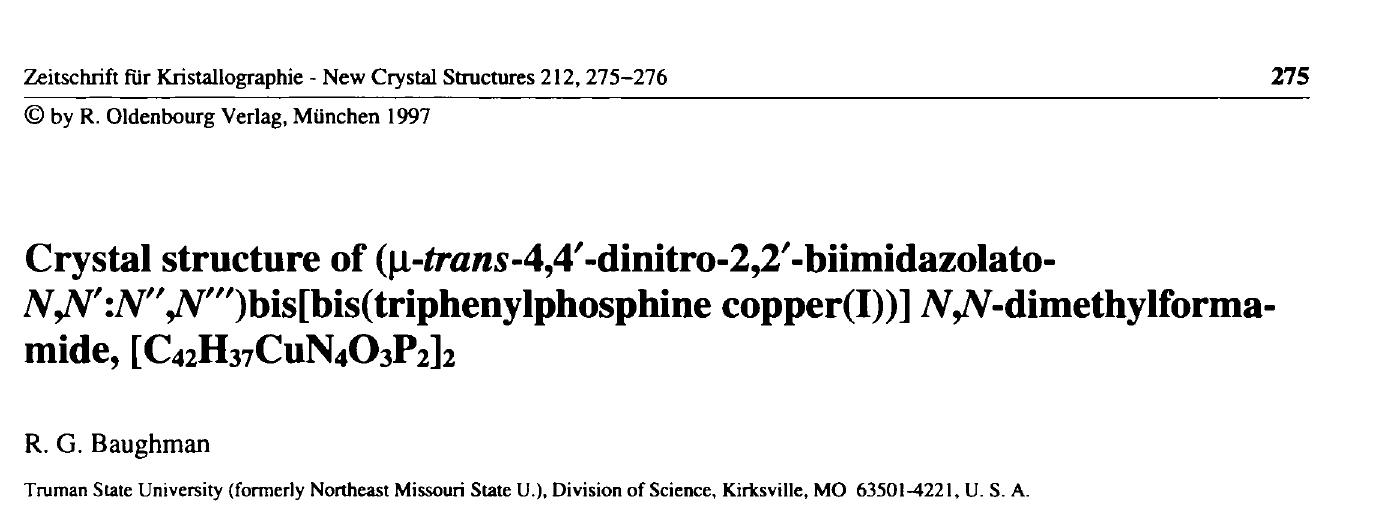
Table 2. Final atomic coordinates and displacement parameters (in Â 2 )